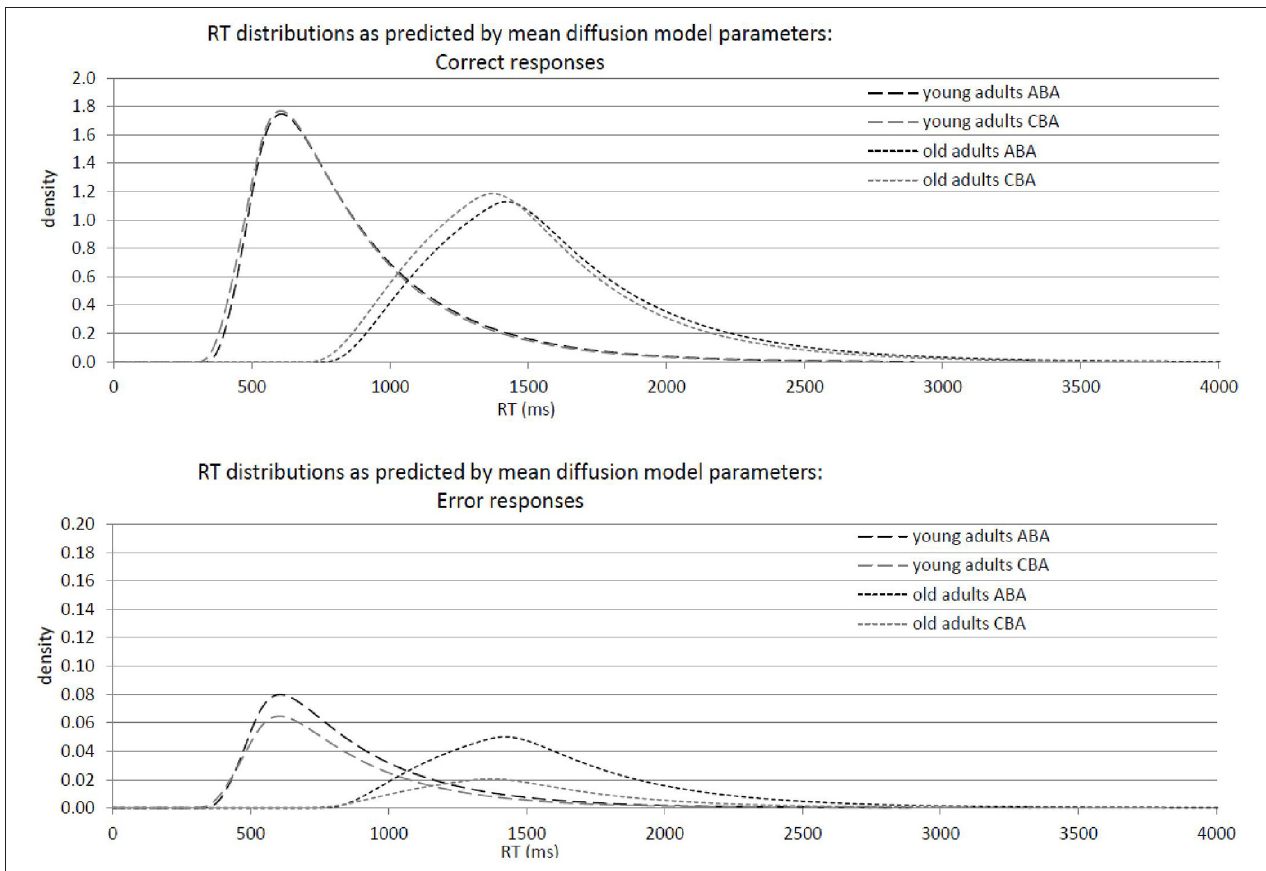
FIGURE 3 | Graphical illustration of response-time distributions resulting from mean diffusion model parameters in ABA and CBA conditions in young adults (18–26 years; N = 22) and older adults (64–79 years; N = 18). Upper panel : Distribution of correct responses. Lower panel : Distribution of error